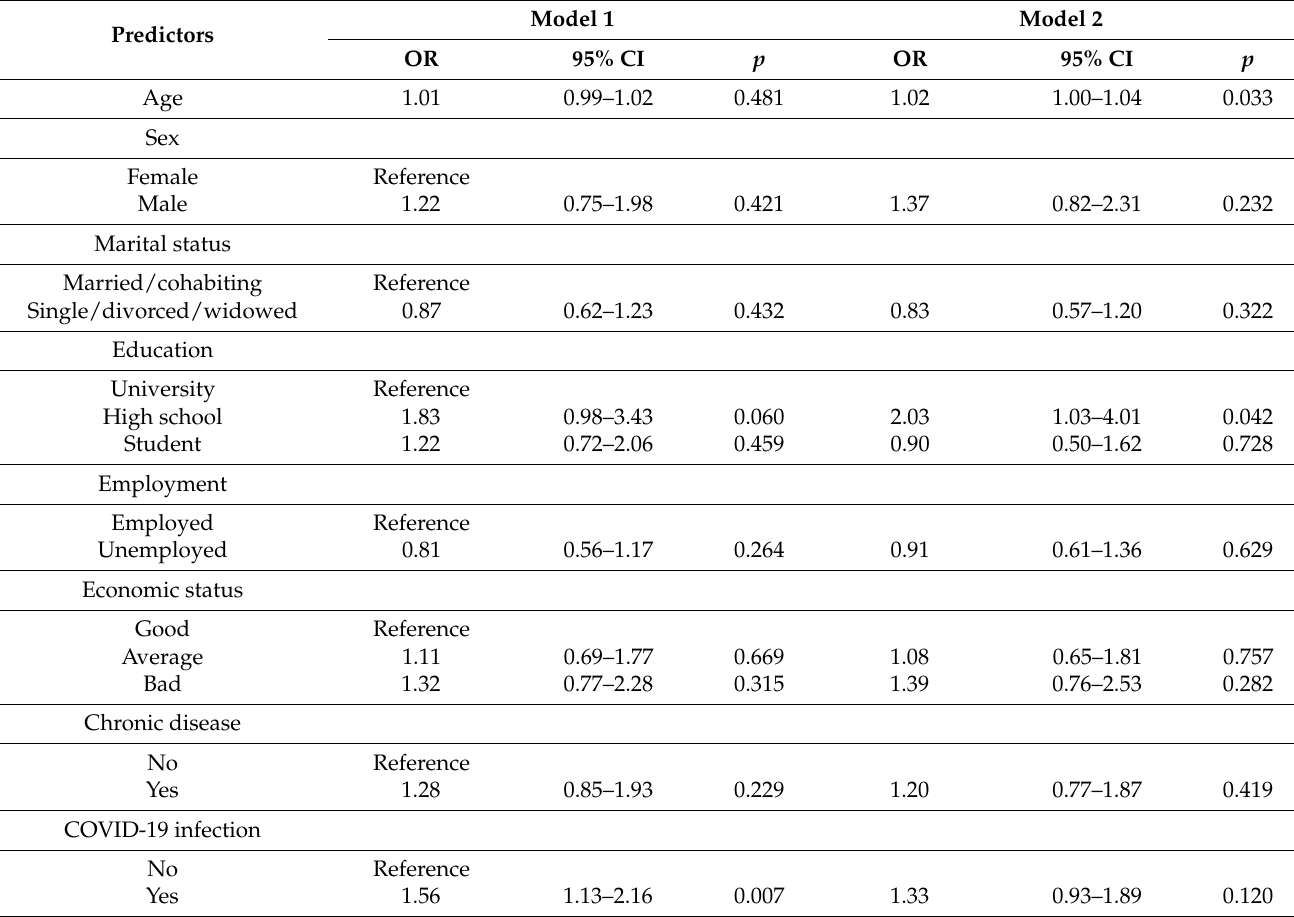
Table 2. Prediction of insomnia disorder (ISI ≥ 15) based on the logistic regression models ( n =